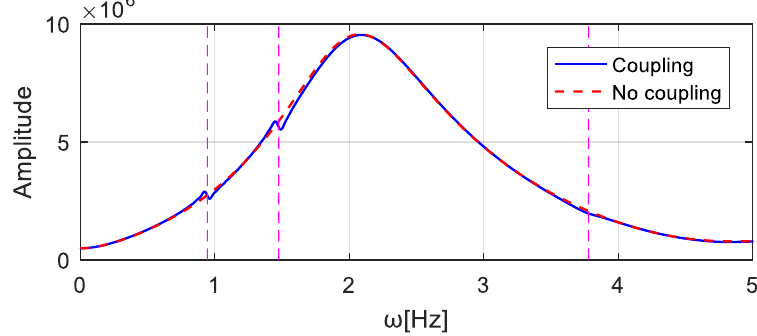
Figure 12. Comparison of the structural responses due to the bump-induced excitations in the frequency domain considering different factors. domain considering di ff erent